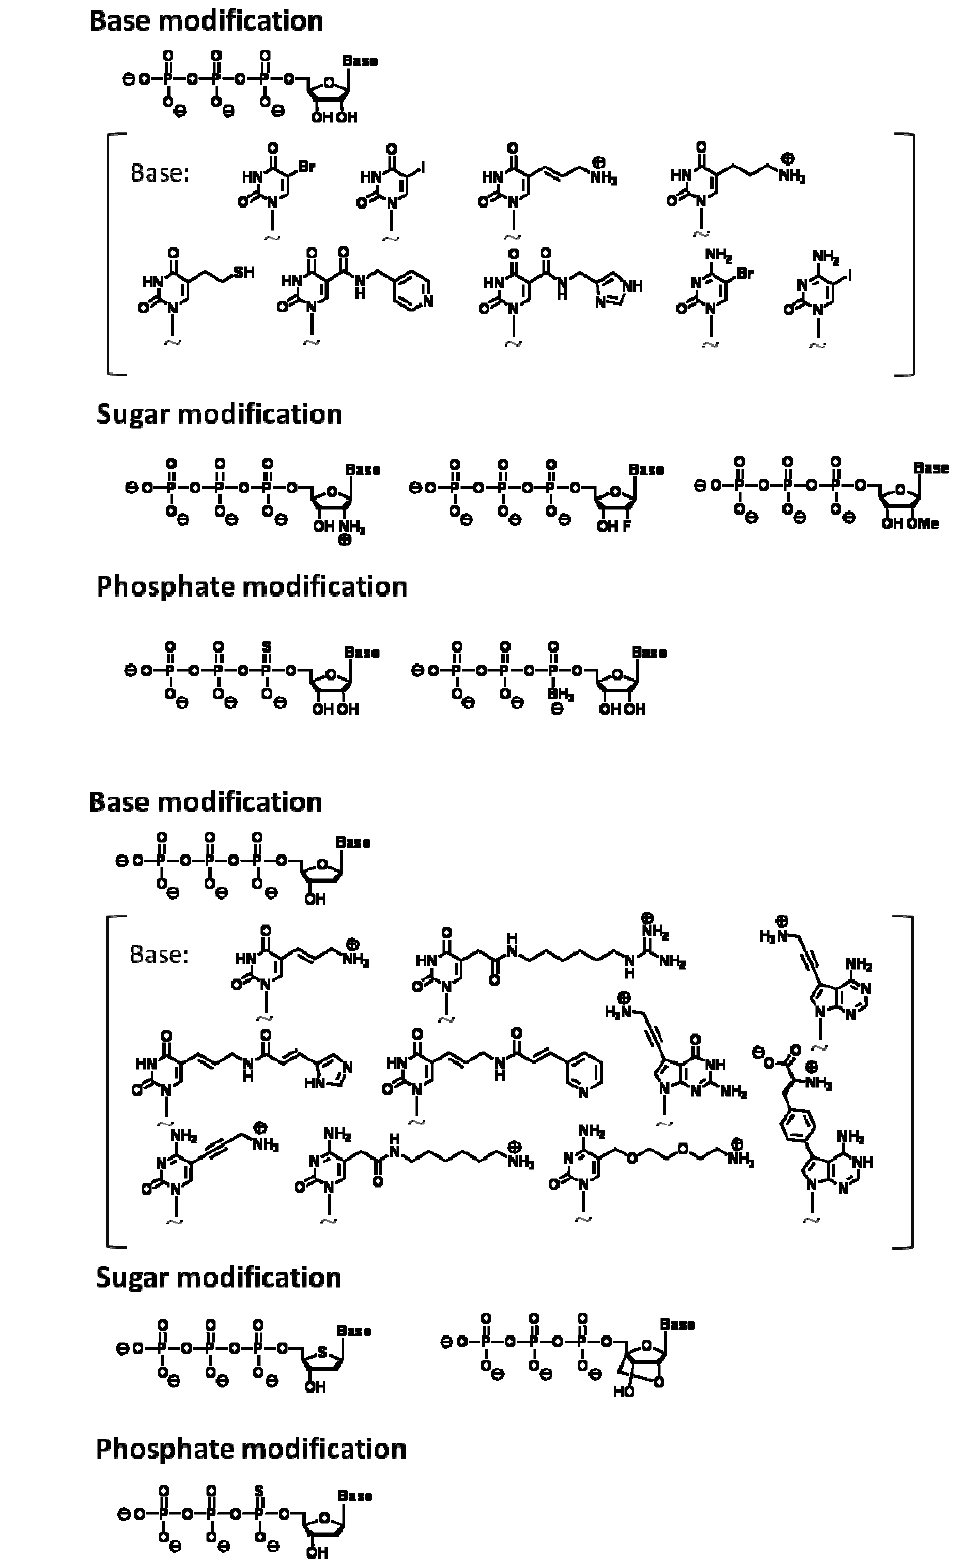
Figure 2. (a) Examples of modified nucleoside triphosphate analogs available for enzymatic RNA polymerization. (b) Examples of modified nucleoside triphosphate analogs available for polymerase chain reaction